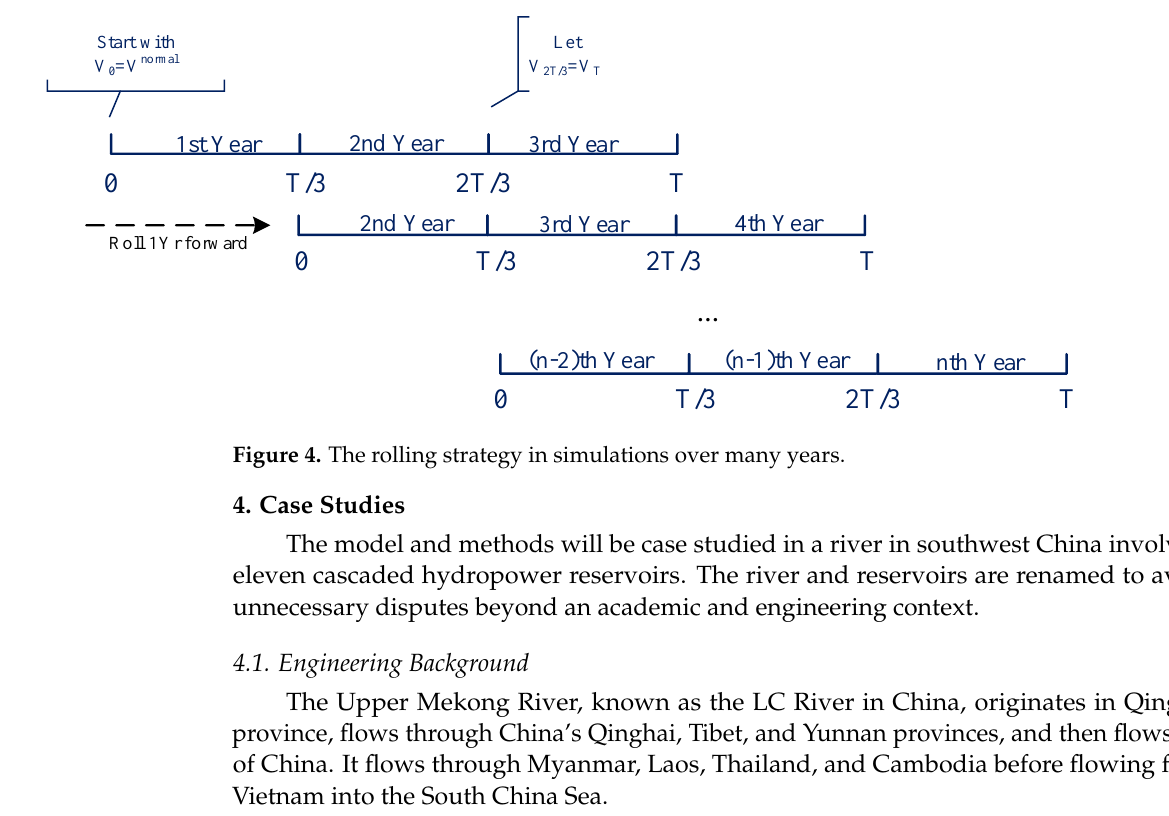
7 of 13 Figure 3. Procedure to update the active planes. 3.2. Simulation Strategy Figure 4 illustrates the rolling strategy to alleviate the dimensional difficulty in